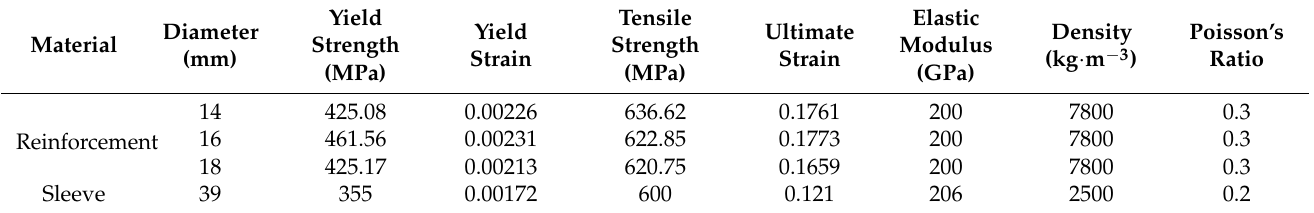
Table 3. Material